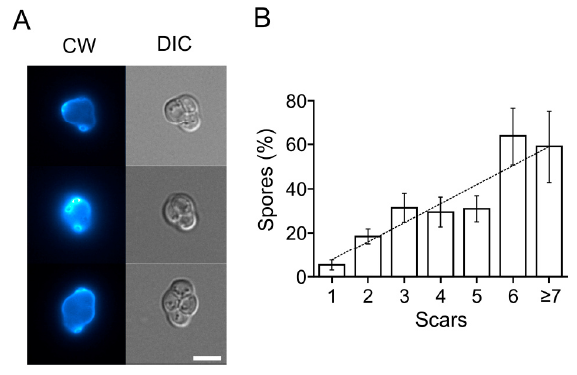
FIGURE 3: Sporulation ability is positively correlated with the number of completed cell cycles. (A) Representative images of yeast tetrads stained with calcofluor white (CW) and visualized under differential interference contrast (DIC). Bar = 5 μm. (B) Quantification of results. 1183 cells analyzed from 8 separate experiments. Kendall's tau = 0.54, Spearman's rho = 0.65, p < 0.001 both tests.